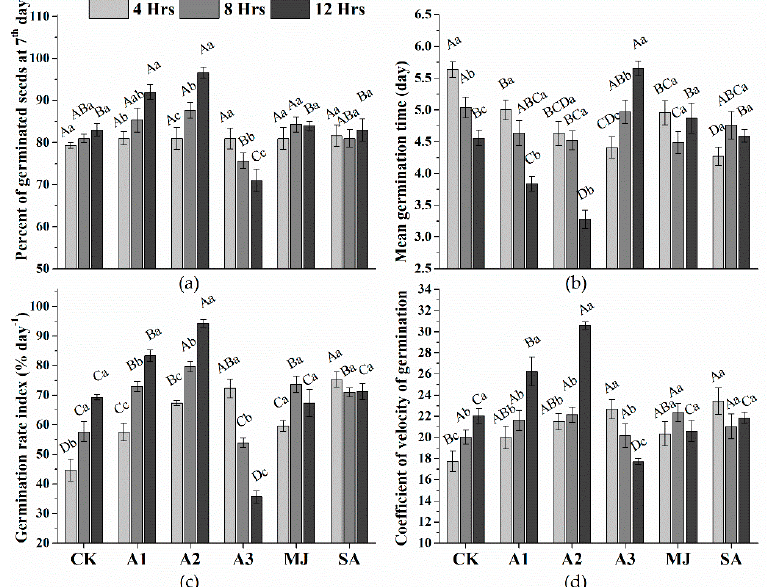
Figure 1. Germination dynamics of AGE (aqueous garlic extracts), methyl jasmonate (MeJA),